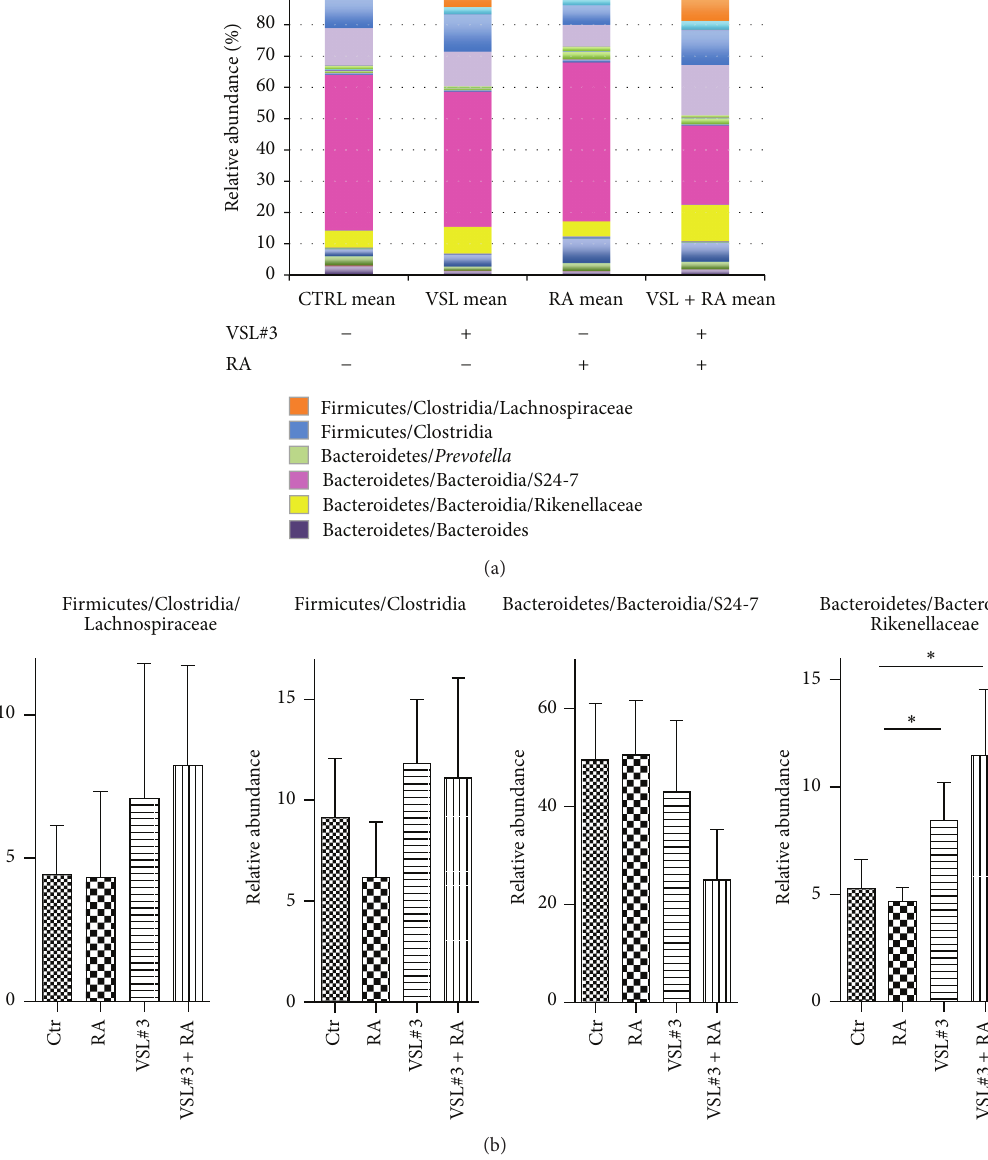
Figure 2: VSL#3 probiotic administration protects against T1D by changing the intestinal microbiota composition of NOD mice. Microbiota profiling by 16S metagenomic analysis was performed on microbiota samples obtained from female NOD mice treated with VSL#3 (VSL#3), RA alone (RA), or VSL#3 + RA or from untreated (Ctr) mice. Luminal contents from individual mice were collected at 12–14 weeks of age before onset of clinical diabetes (hyperglycemia), and a microbial survey of the metabolically active fecal community members was performed by pyrosequencing of the barcoded 16S rRNA gene. Between 15000 and 20000 sequences/samples were used in the analysis. Good coverage indices of > 0,99 were observed for all samples. (a) Relative abundances of the different murine intestinal families in the four groups of mice. (b) The data are expressed as the mean ± SEM of the relative abundances of the major murine intestinal phyla. ∗ 𝑝 < 0.05 by one-way ANOVA test with Bonferroni’s